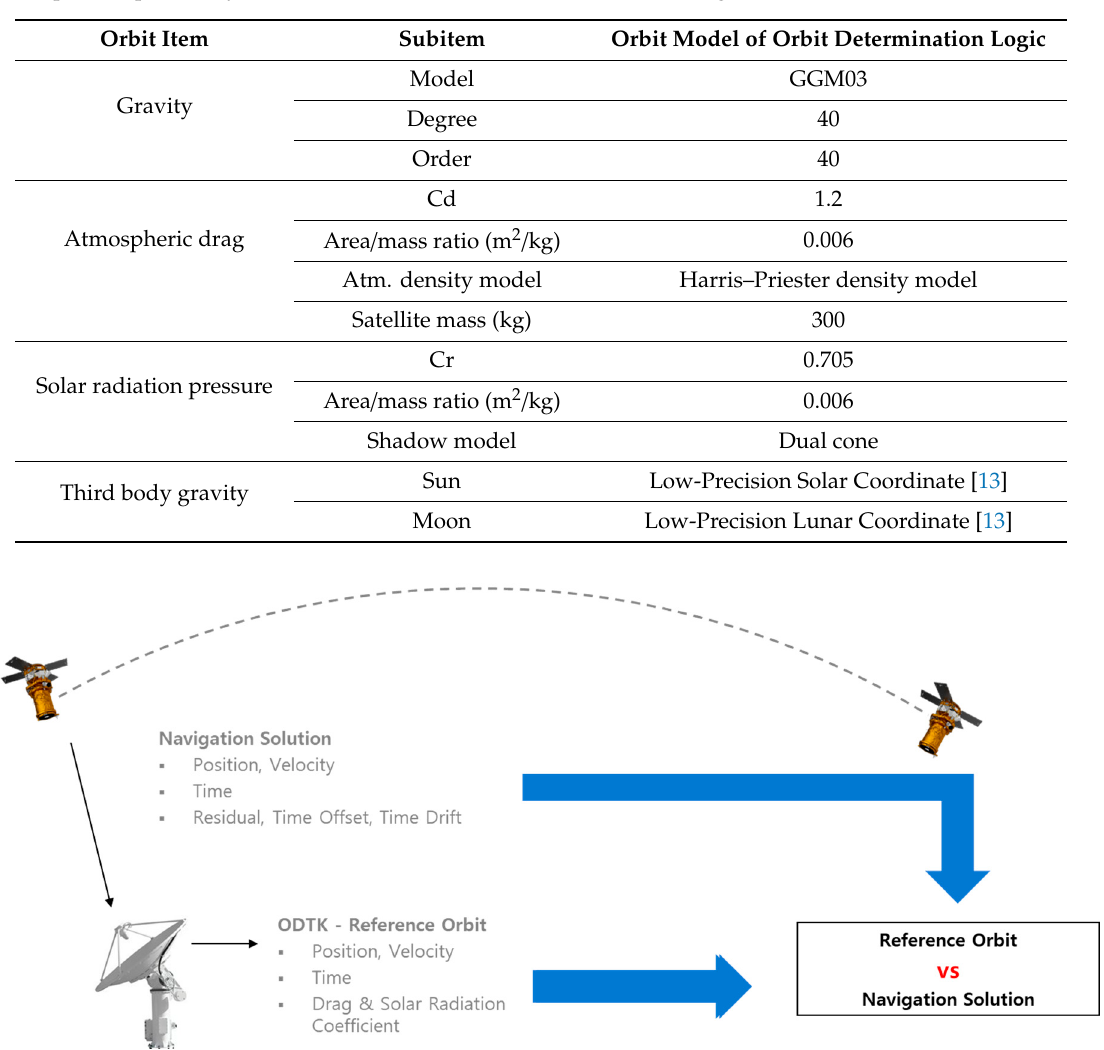
Table 5. Summary of orbit model including gravity and non-gravity models. The orbit model was operated practically in the on-board real-time orbit determination logic of GPS-12.